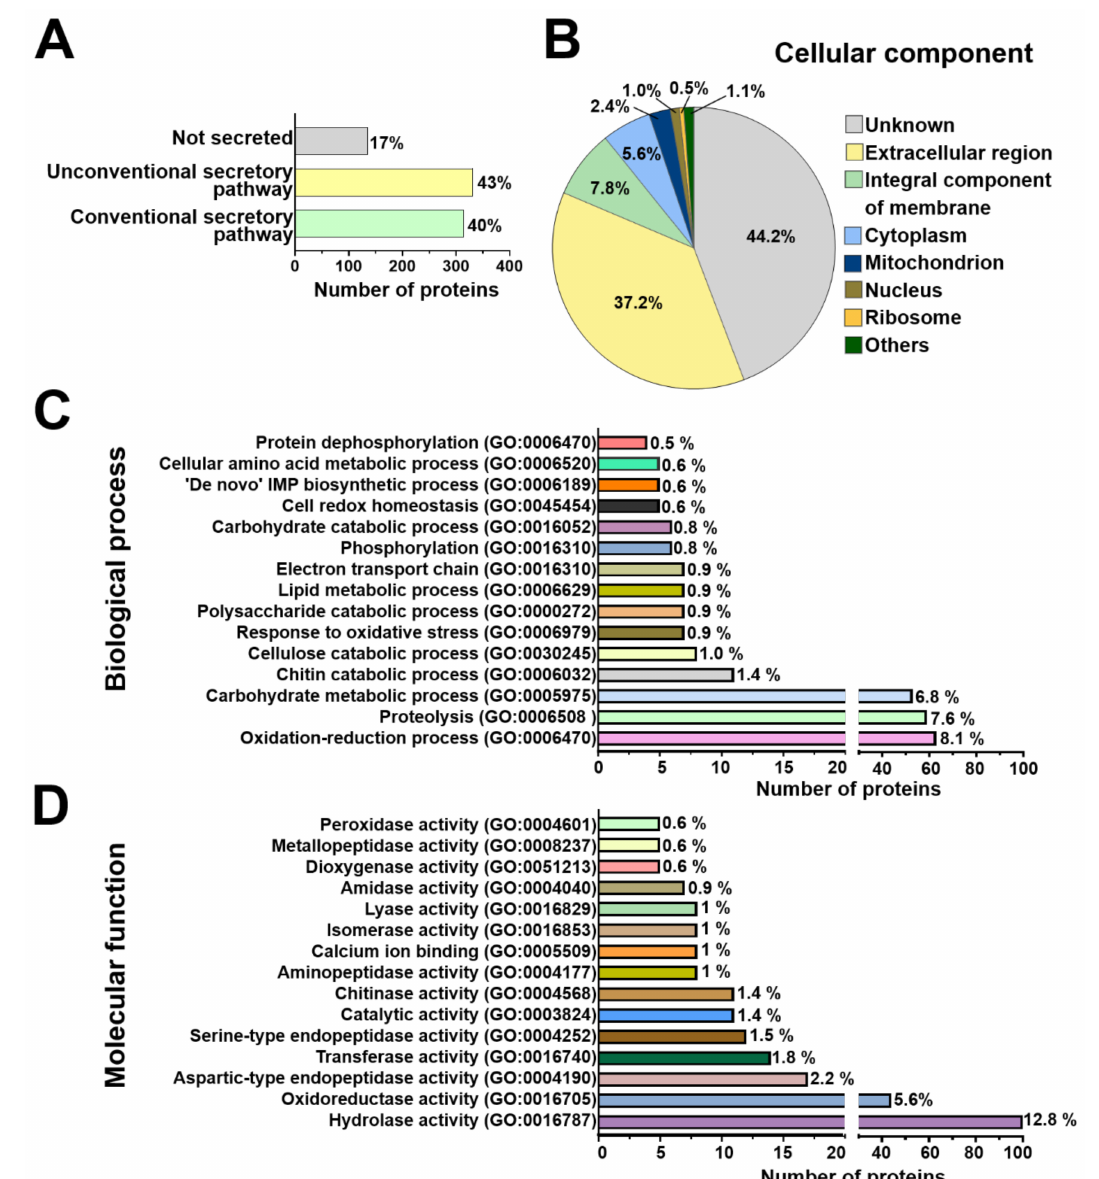
Figure 4. Prediction of putative secretion pathways and functional annotation of T. atroviride secreted proteins. ( A ) Prediction of secretion pathways of T. atroviride proteins during its interaction with Arabidopsis . ( B ) Pie chart for the cellular component of T. atroviride secreted proteins predicted by Blast2GO. Others included peroxisome, endosome, multivesicular body, cytoplasmic stress granule, cytoplasmic vesicle membrane, endoplasmic reticulum, and eukaryotic translation initiation factor 3 complex. ( C ) Horizontal bar graphic for the top 15 biological processes of T. atroviride -secreted proteins predicted by Blast2GO. Bars represent the number of proteins implied in a specific biological process. ( D ) Horizontal bar graphic for the top 15 molecular functions predicted by Blast2GO. The prediction of secretion pathways was performed using SECRETOOL [29], SecretomeP v2.0 [30], and the OutCyte v1.0 [31]. Functional annotation was performed with Gene Ontology (GO) terms using Blast2GO software